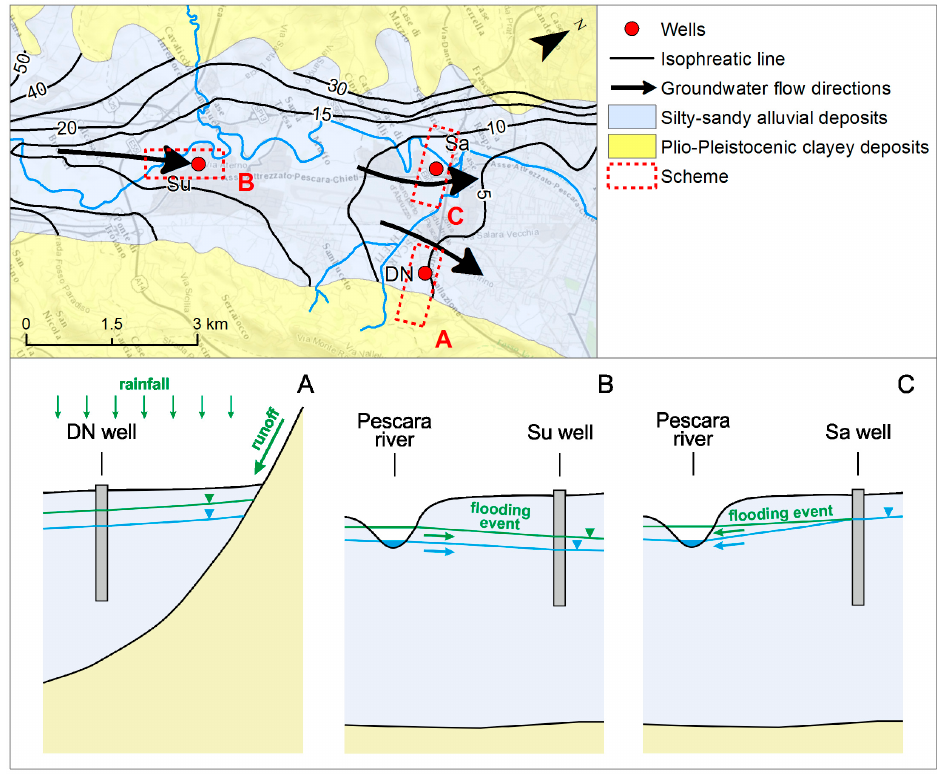
Figure 17. Refined conceptual model of groundwater flow paths and groundwater/surface water